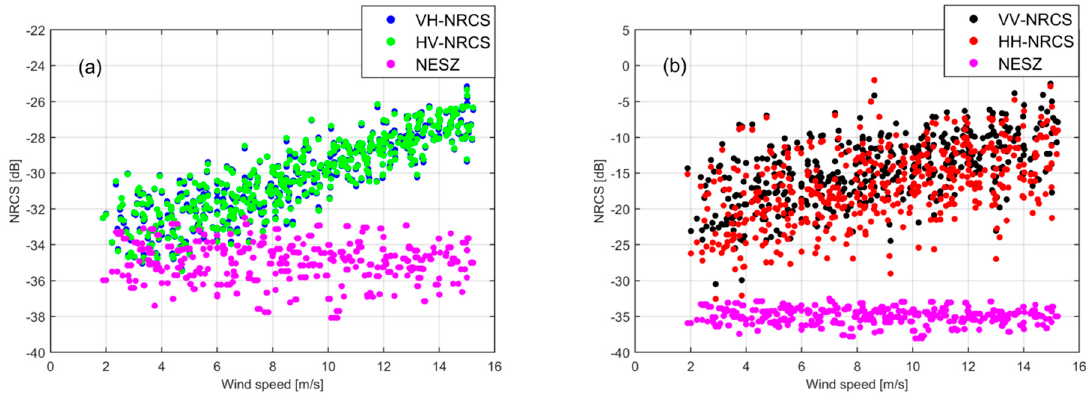
Figure 13. Sigma naught versus in situ ERA-Interim wind speed for ( a ) cross- and ( b ) co-polarized data.